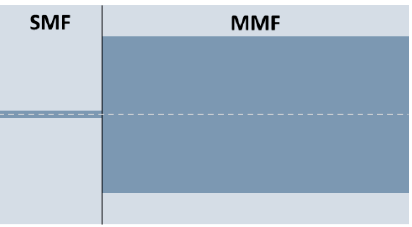
Figure 2. Single-mode fiber (SMF)-multimode fiber (MMF) structure used in the simulations to illustrate the main features of multimode interference (MMI) devices.